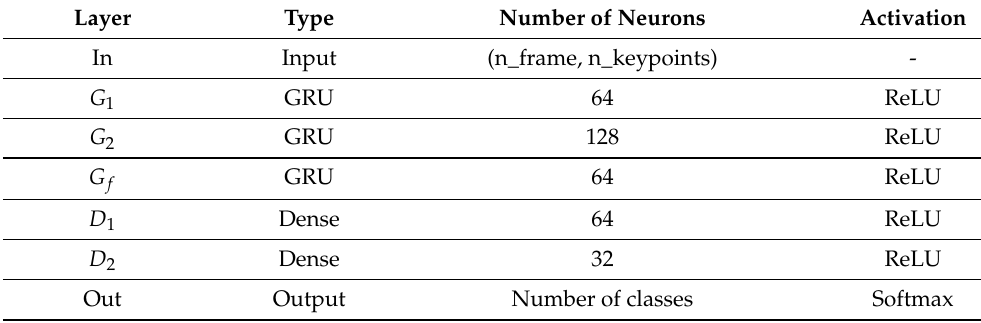
Table 1. GRU model layers and parameters.